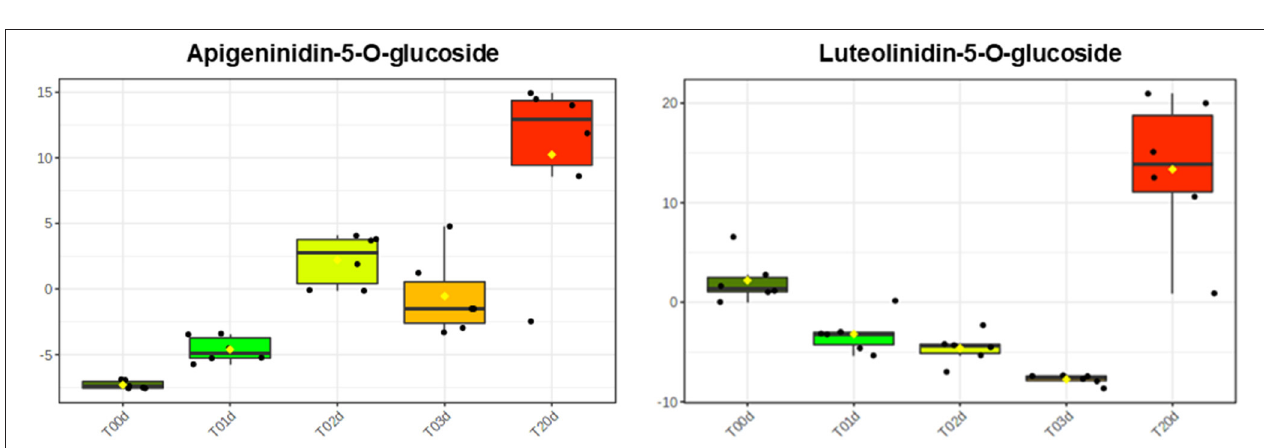
FIGURE 5 | Relative abundance of different subclasses of polyphenols detected by LC/HRMS analysis in A. filiculoides challenged with 5 ◦ C and moderate light intensity (700 PPFD) for 20 days. Quinic acid, flavanones, and flavones were reported in a different framed histogram with higher y-axis scale for better visualization. Data are mean ± SE of six biological replicates. Different letters corresponded to statistically significance differences according to two-way ANOVA followed by Tukey’s multiple comparison test ( P < 0.001).